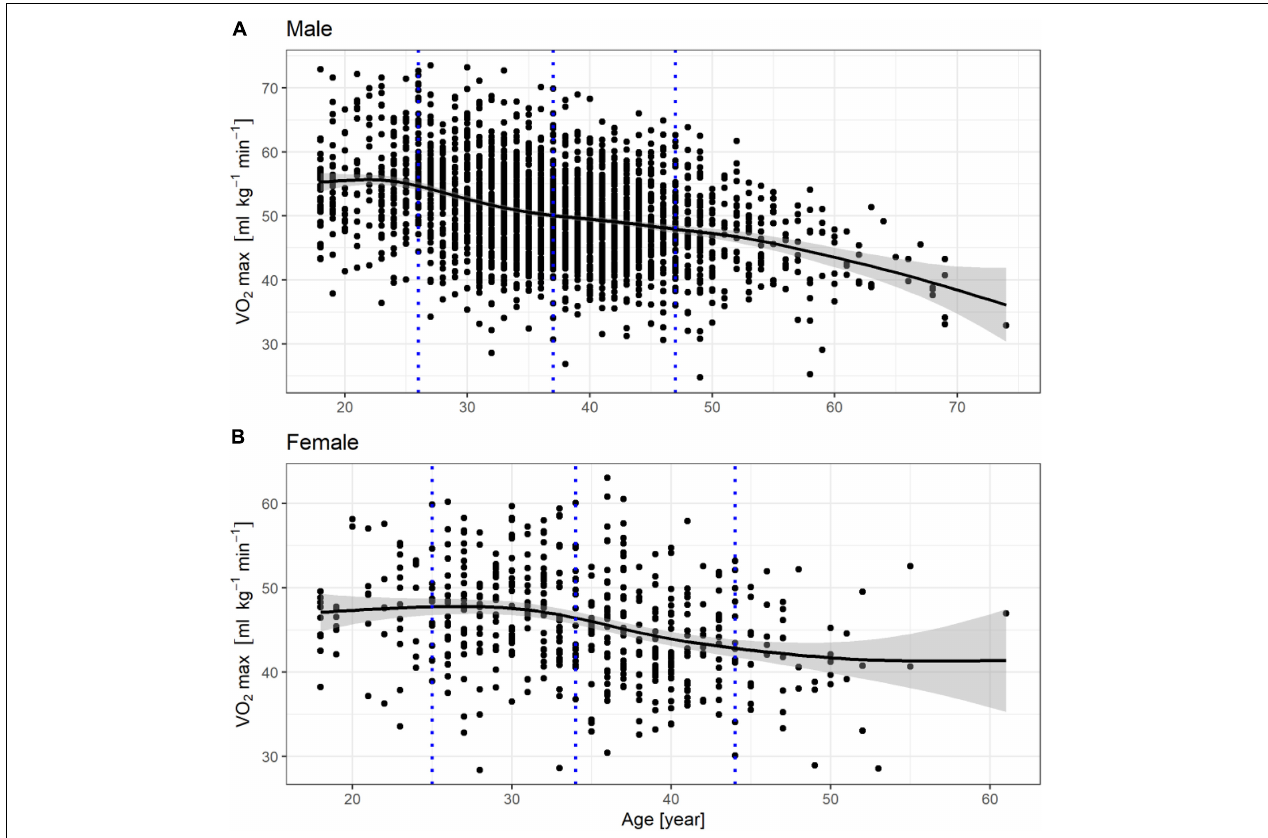
FIGURE 1 | Fitness level distribution in males (A) and females (B) , the gray dotted lines represent the 10th, 50th, and 90th quantile in the population.